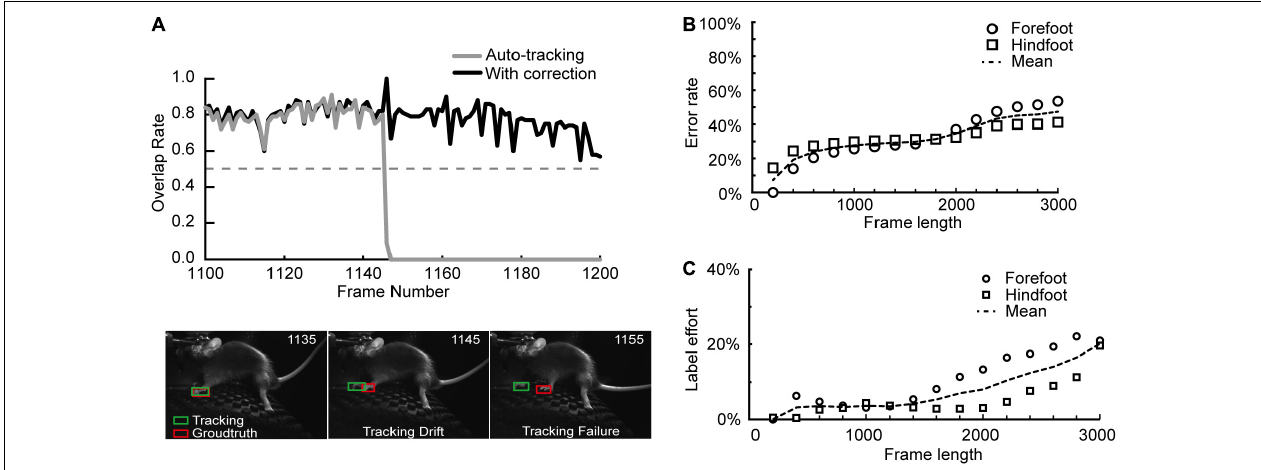
FIGURE 2 | Few human corrections are helpful to increase accuracy. (A) In a practical auto-tracking procedure (the gray line in the top plot), the tracking result (the green box) can match the ground truth (the red box) most of the time (the bottom left inset). Tracking drift may occasionally happen due to the fast movement of the object or another similar object nearby (the bottom middle inset). The tracking drift can evolve to tracking failure without a correction (the bottom right inset). However, a single correction on the earliest tracking drift frame can successfully rescue the subsequent tracking failure (the black line in the top plot). X -axis: Frame number of the video; Y -axis: overlap rate with the evaluation threshold of 0.5. (B) The tracking error rates of forefoot and hindfoot increased with video frame length’s elongation. Error rate: the percent ratio of failed frames in the total frames. N = 3 videos. (C) Fewer human corrections than error frames are enough to fix the tracking failures and achieve 100% accurate tracking results. A 100% accuracy: all the frames’ OR values are above 0.5; label effort: the percent ratio of frames needs to be corrected to keep 100% accuracy. N = 3